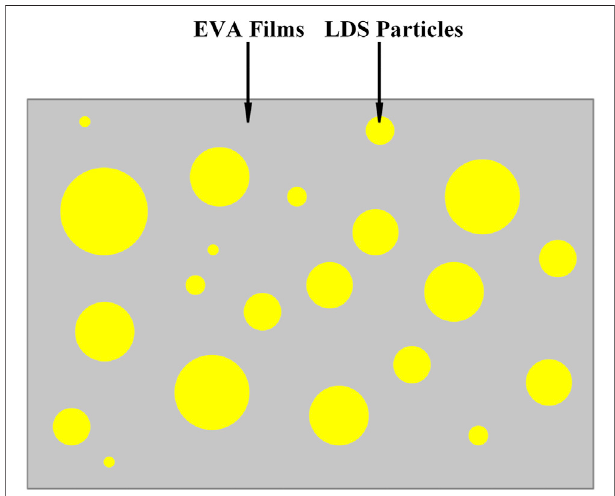
FIGURE 1 | Simulated model with LDS particles of different sizes in EVA fi lms.